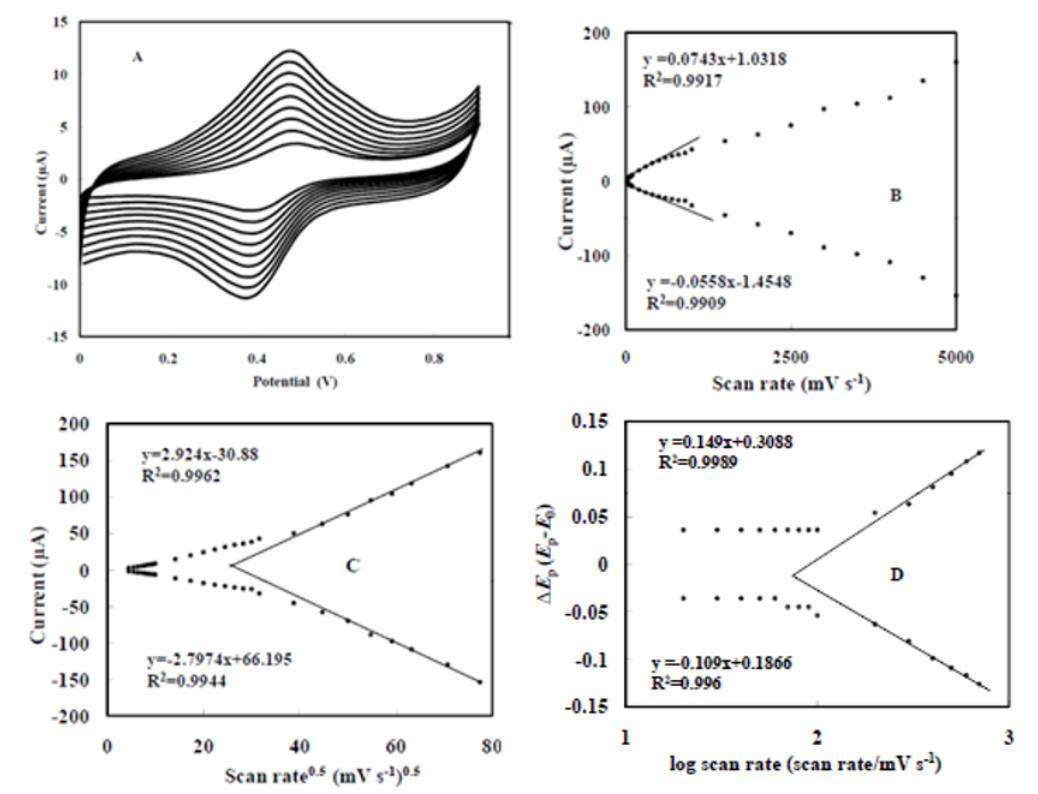
Figure 3. (A) Cyclic voltammogram response Cu- complex/MWCNTs/GCE in buffer solution (pH=5) at scan rates ( inner to outer ) 20, 30, 40, 50, 60, 70, 80, 90 and 100 mV s -1 Inset: plot of current vs. scan rate (B) and square root of scan rate (C). (D) variation of peak potential separation vs. log ν